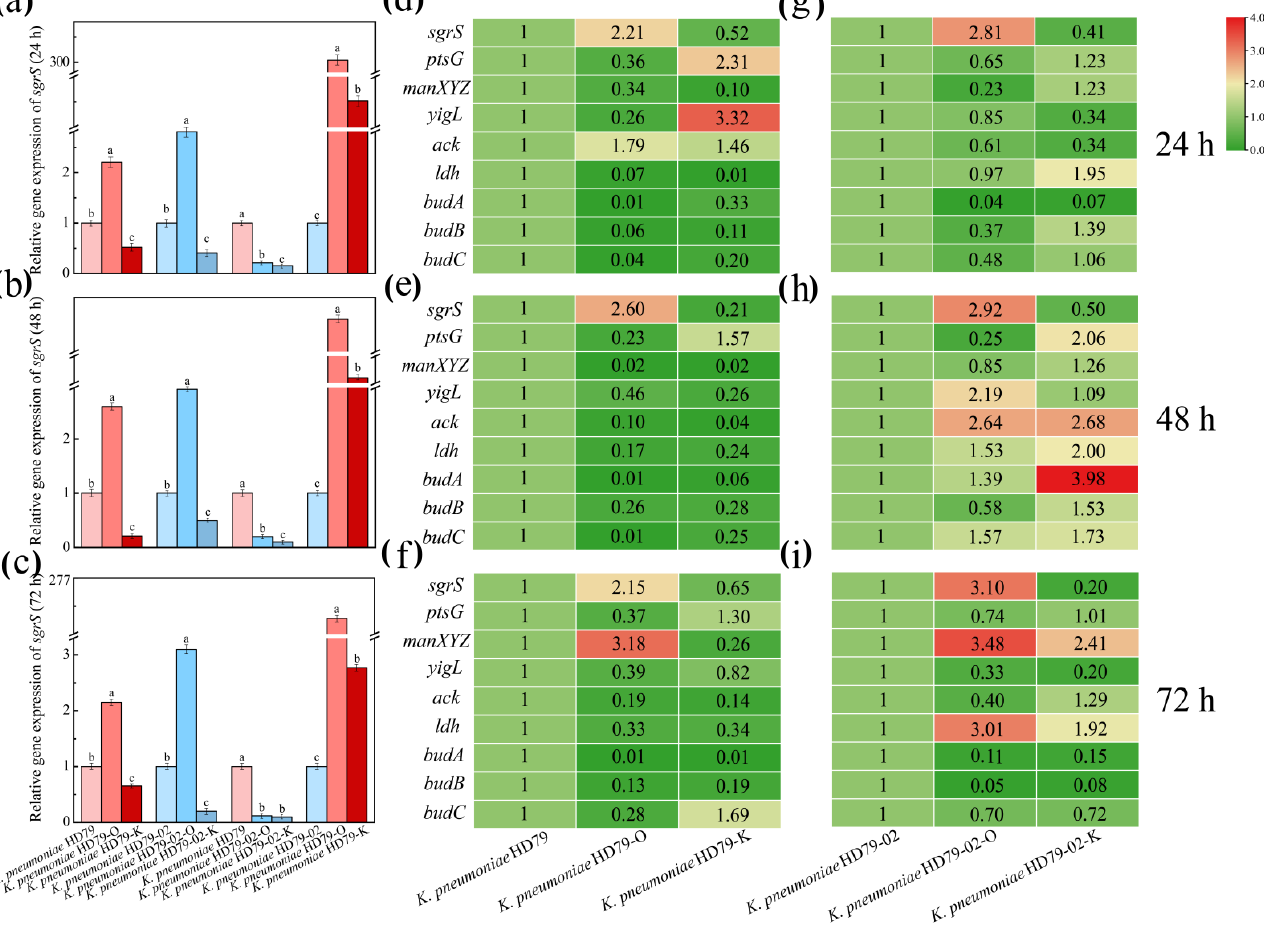
Figure 5. Changes of related genes in K. pneumoniae HD79 series strains and K. pneumoniae HD79-02 series strains at 24 h, 48 h, and 72 h of fermentation. ( a – c ) Relative expression levels of sgrS gene in different strains in three time periods; a, b and c on the bar chart are the results obtained by SPSS significance analysis. ( d – f ) Relative expression levels of each gene in HD79 series strains in three time periods; ( g – i ) Relative expression levels of each gene in HD79-02 series strains in three time periods.